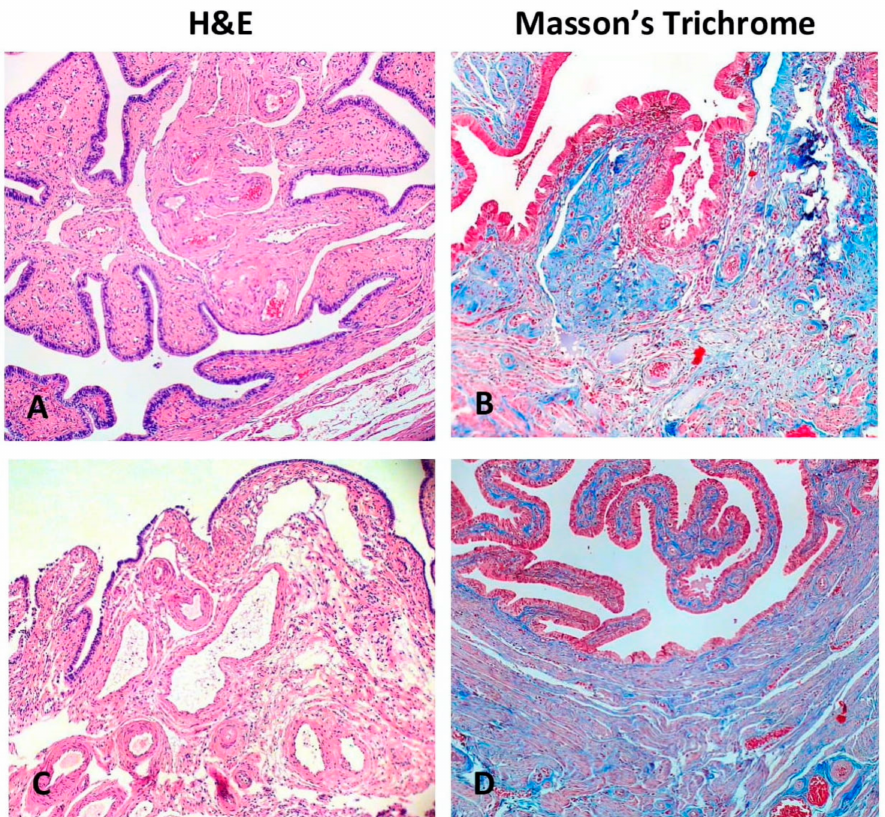
Figure 2. Hematoxylin–eosin and Masson’s trichrome stained sections of the human oviduct in pa- tients with uterine myoma ( C , D ) and without ( A , B ). Hematoxylin–eosin staining ( A , C ) demonstrates the oviduct mucosa. With Masson’s trichrome staining ( B , D ), collagen deposits were stained blue and muscle fibers were stained red. The prevalence of collagen deposits is common for the central part of mucosal folds, while in the muscular layer, it was located between muscle bundles. Total magnification: ×